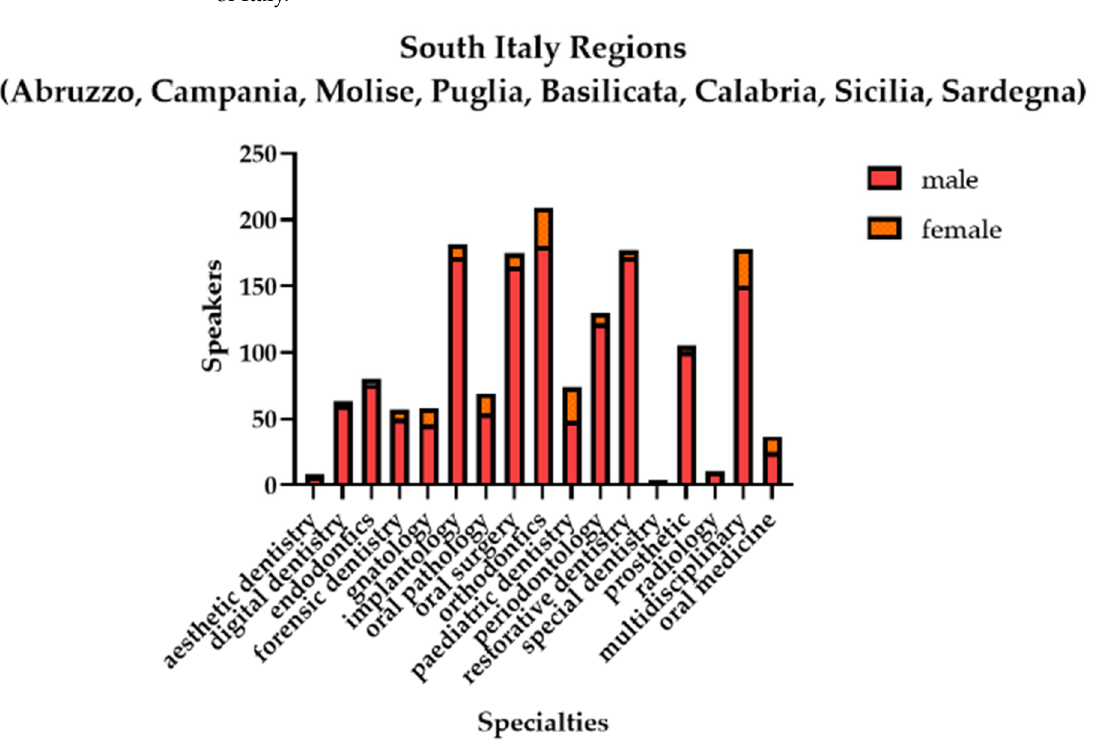
Figure 7. Graphical representation of the gender distribution of the speakers in the southern area of Italy.